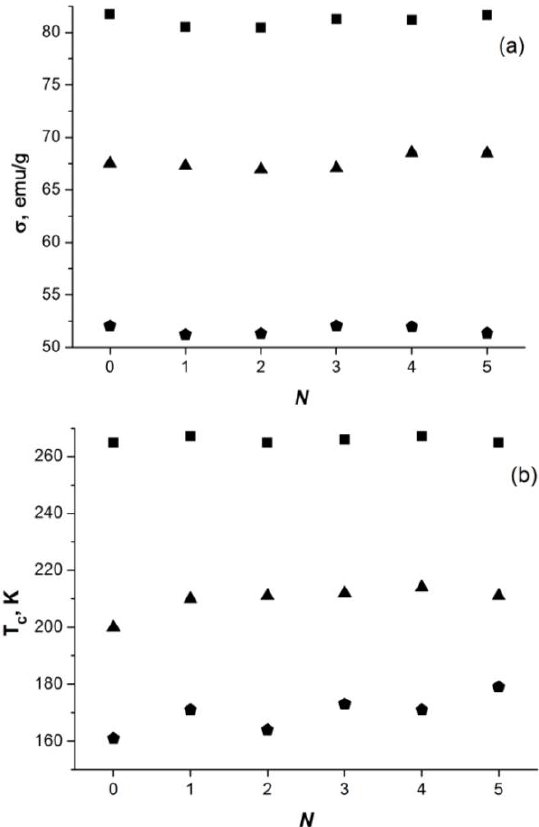
Fig. 3 . Magnetization (a) and Curie point (b) of thermal-cycled of cycles ( N = 0 corresponds to the initial